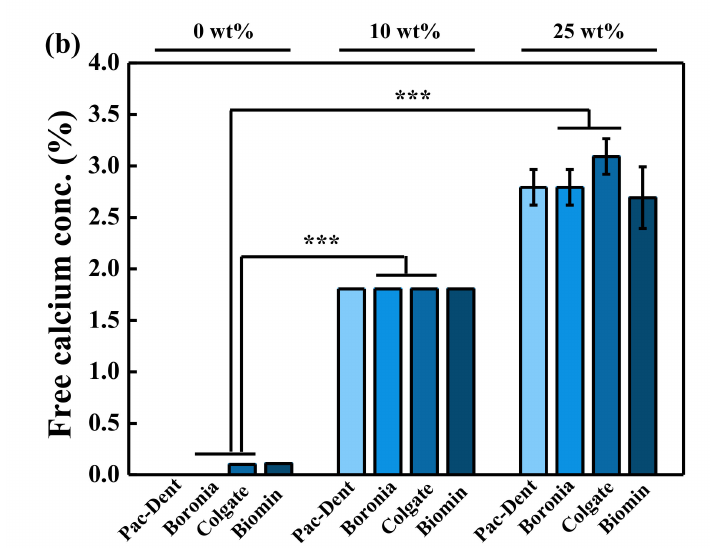
Figure 5. Free calcium concentration of different brands of toothpaste containing ( a ) TCP powder only and ( b ) TCP/ACP mixed powder (*** p < 0.001). The toothpaste containing only TCP powder had a significantly higher calcium concentration than the normal toothpaste. Furthermore, the toothpaste containing the TCP/ACP mixed powder had a higher calcium concentration than the toothpaste containing only TCP